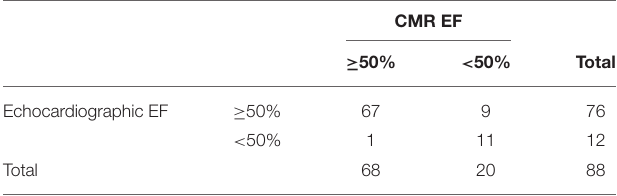
TABLE 3 | Patients assessed by echocardiography and CMR at EF 50% threshold.